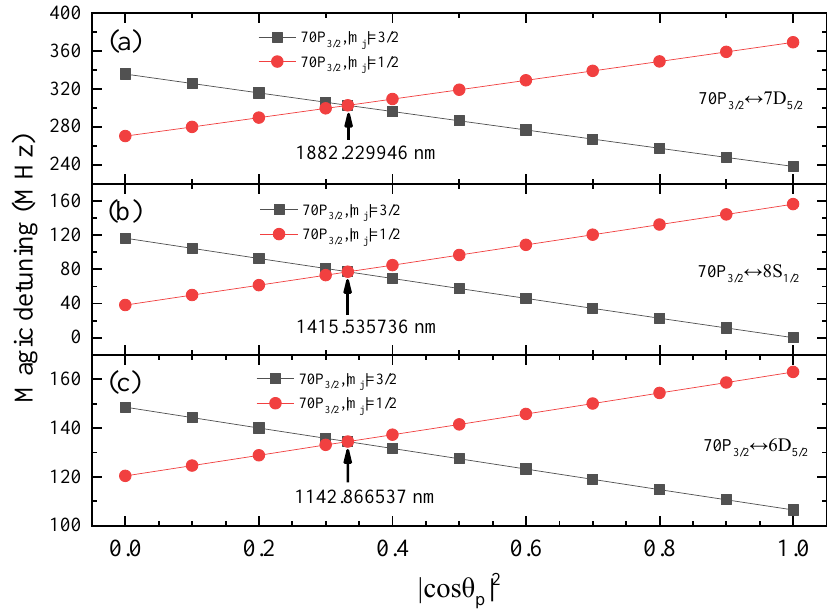
Figure 5. The dependence of magic detuning for the 6 S 1/2 ↔ 70 P 3/2 transition near different auxiliary (cid:12) (cid:12) 2 in the case of linearly polarized light. ( a ) 70 P transitions on (cid:12) cos θ p (cid:12) ( b ) 70 P 3/2 ↔ 8 S 1/2 auxiliary transition; ( c ) 70 P 3/2 ↔ 6 D 5/2 auxiliary transition.